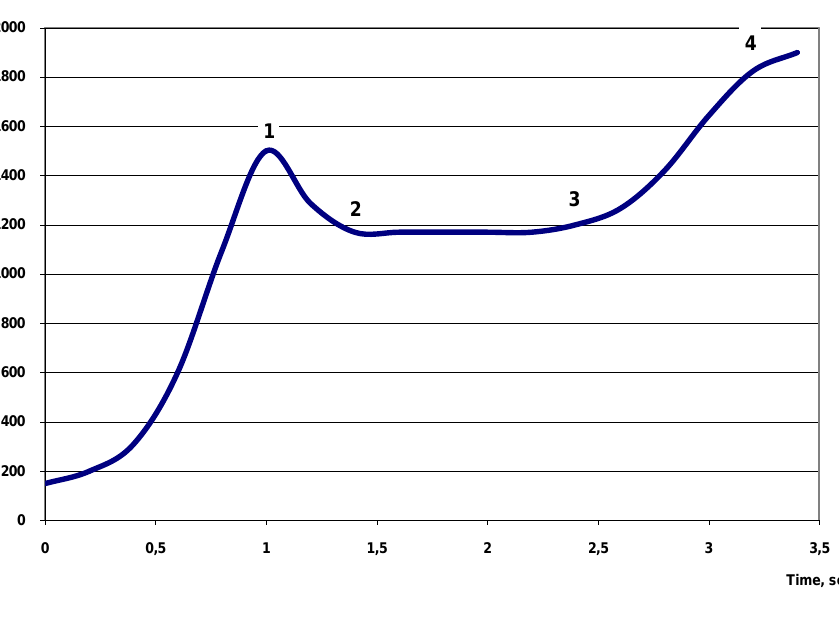
Diagram 1. Results of snatch with weight 50% from